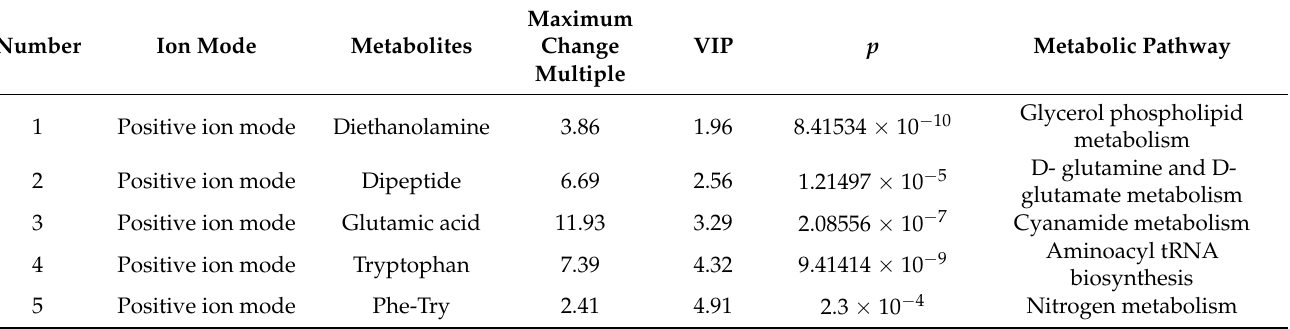
Figure 11. Volcanic diagram of positive ions in the plasma between study group and the control group. Abscissa was the change multiple of each substance in two groups. The ordinate is the P value of the t test, which is expressed by –logP. The dots in the picture represent metabolites, which represent the size of the VIP value. The red dots represent an increase in metabolites. The blue dots represent metabolites that are falling. Gray dots represent no difference in metabolic products. Table 2. Differential metabolites in positive ion